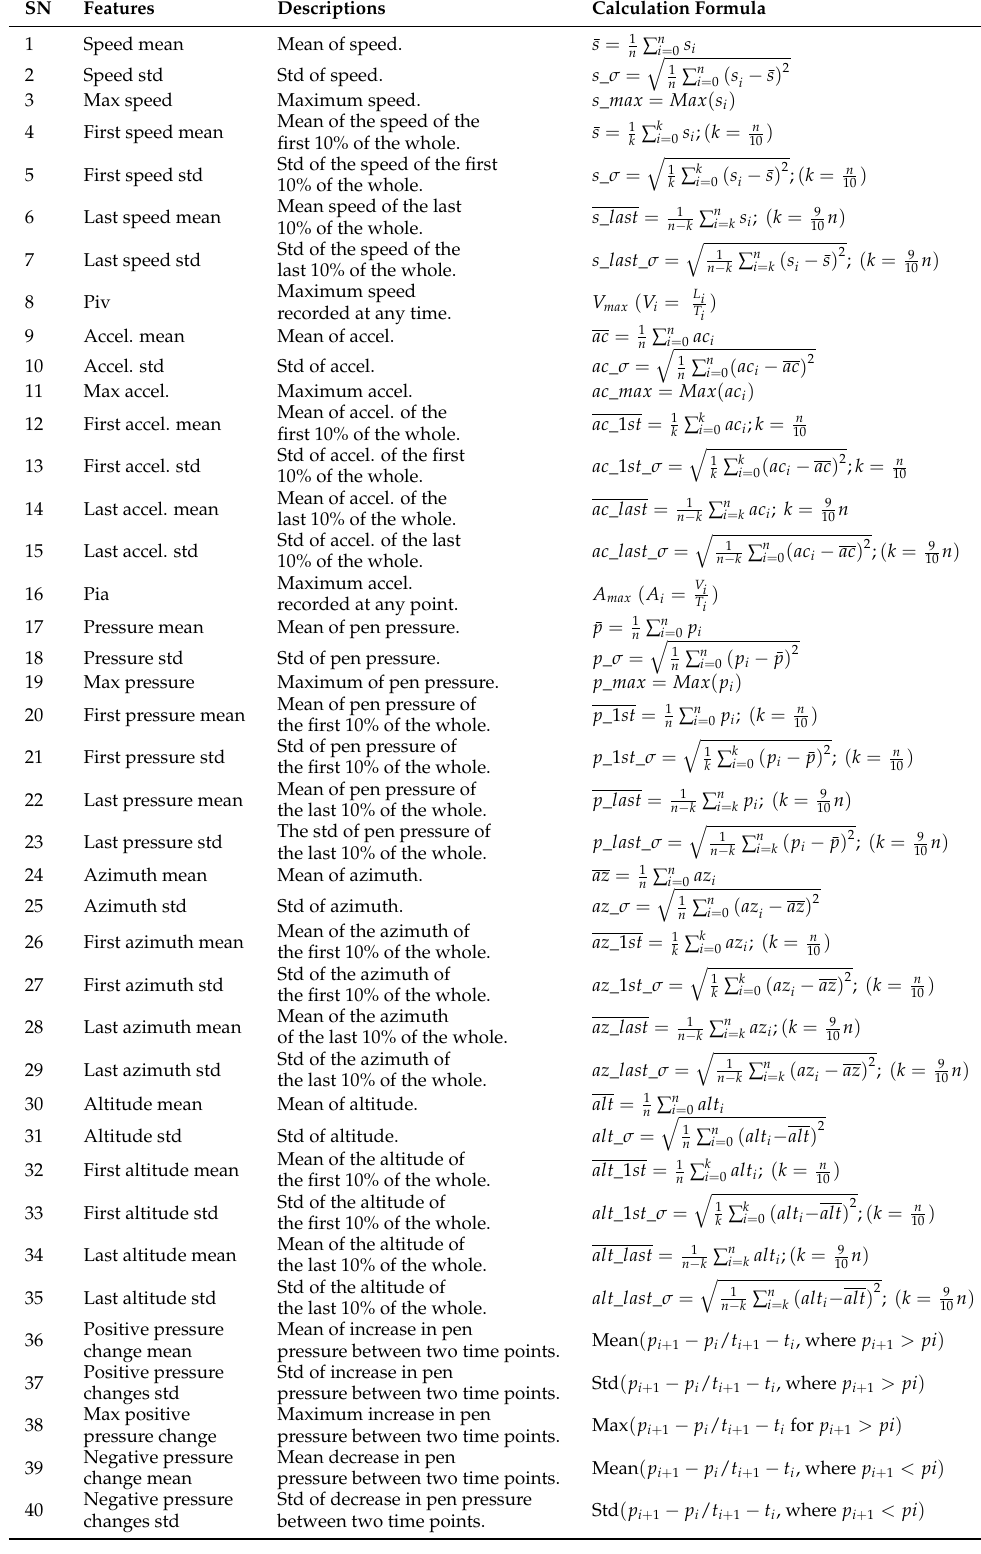
Table 2. List of extracted features names, their descriptions, and calculation